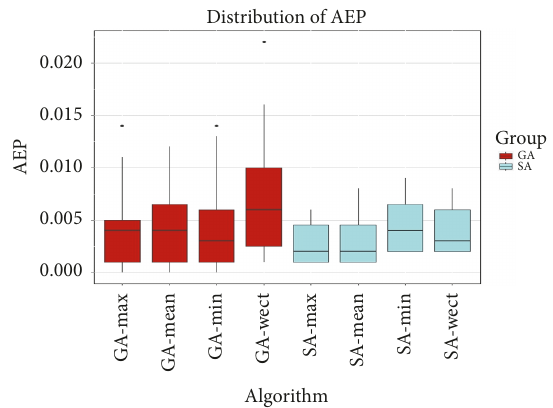
Figure 6: Box plots of AEP for the algorithms for small number of orders.